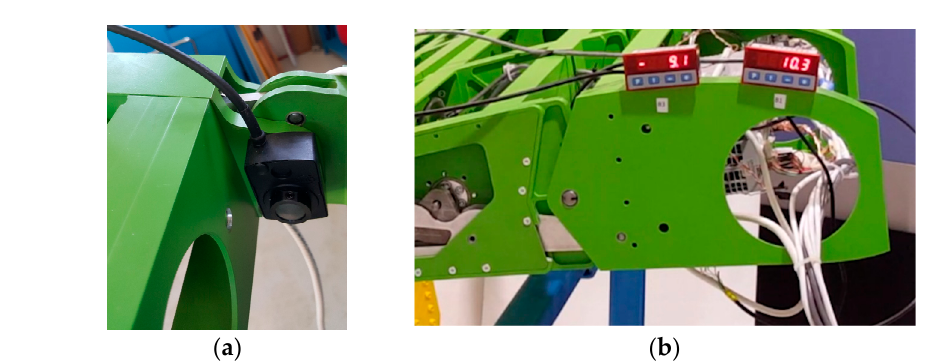
Aerospace 2018 , 5 , x FOR PEER REVIEW Figure 15. Sensing strategy: ( a ) hinge encoder ( b ) and rotations displays. Figure 15. Sensing strategy: ( a ) hinge encoder ( b ) and rotations displays.